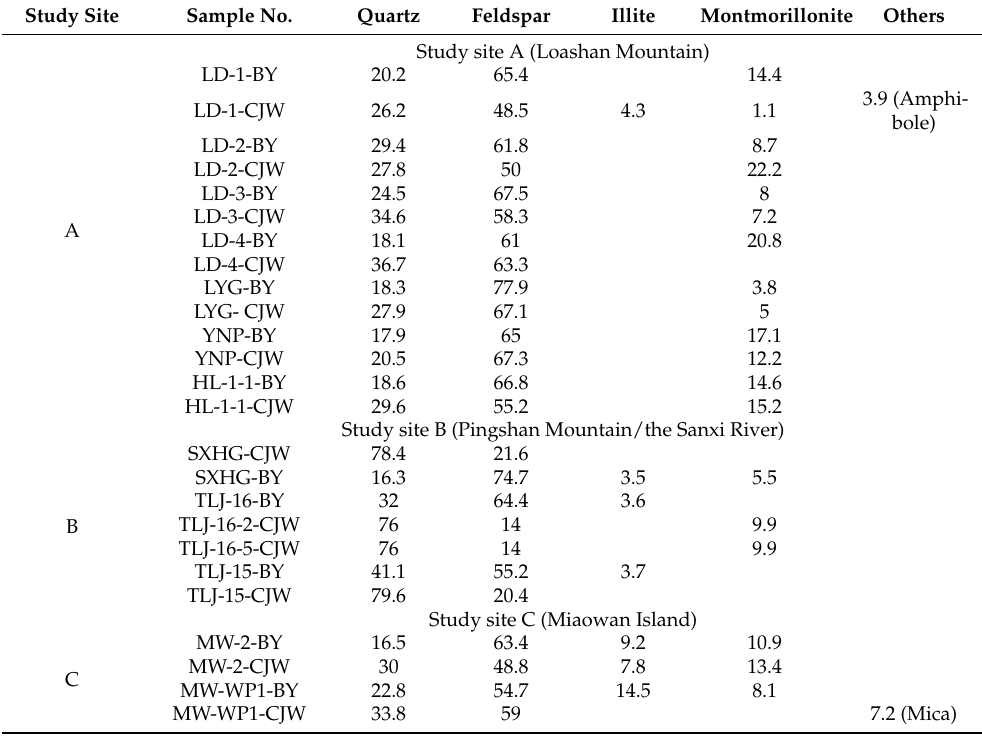
Table 2. Percentage of minerals of weathering pits and parent rocks of the three study sites